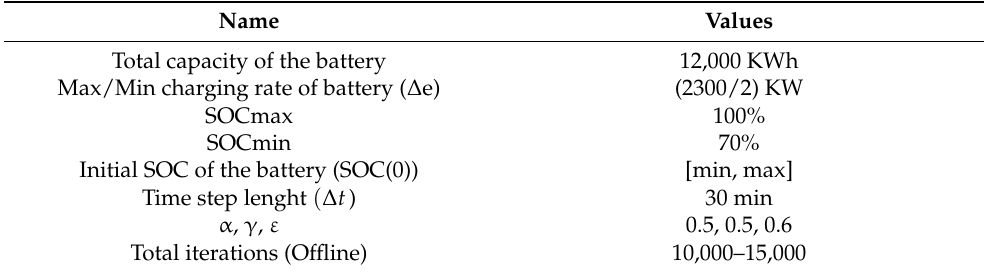
Table 1. Chosen parameters of the microgrid used in this